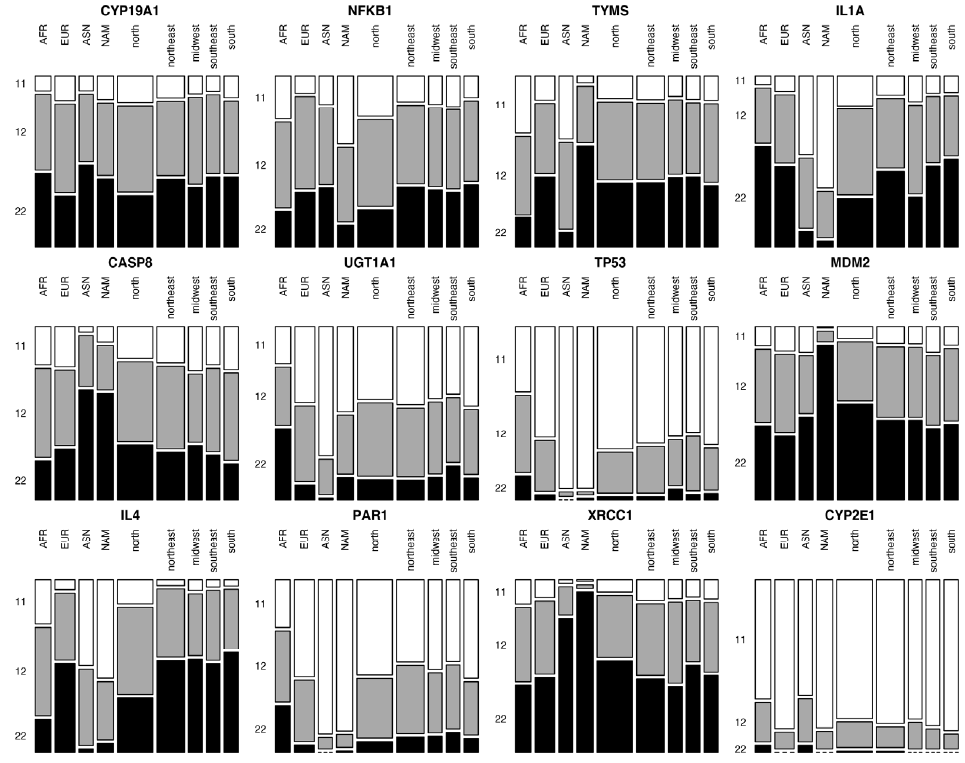
Figure 1. Genotype distribution of the markers across the studied populations. Genotype distribution of each marker in all analyzed populations: African, European, Asian, Native American and the five regions of Brazil (North, Northeast, Midwest, Southeast and South). 11, deletion/deletion; 12, deletion/insertion; 22, insertion/insertion.